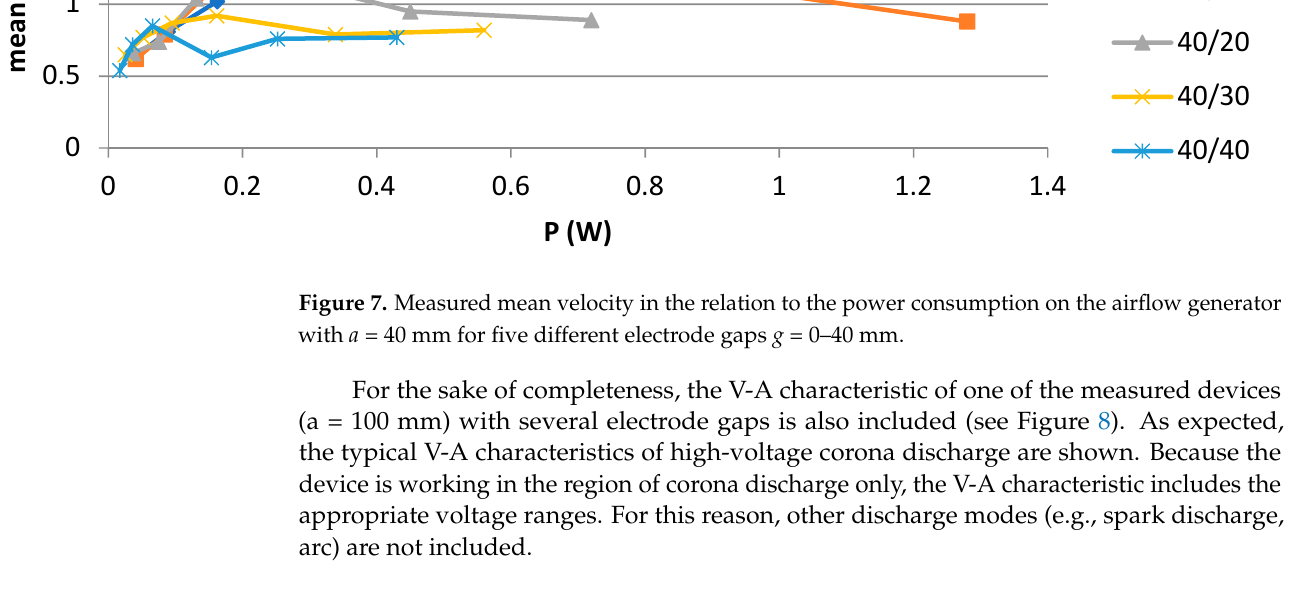
Figure 7. Measured mean velocity in the relation to the power consumption on the air fl ow gener- ator with a = 40 mm for fi ve di ff erent electrode gaps g = 0–40 mm.